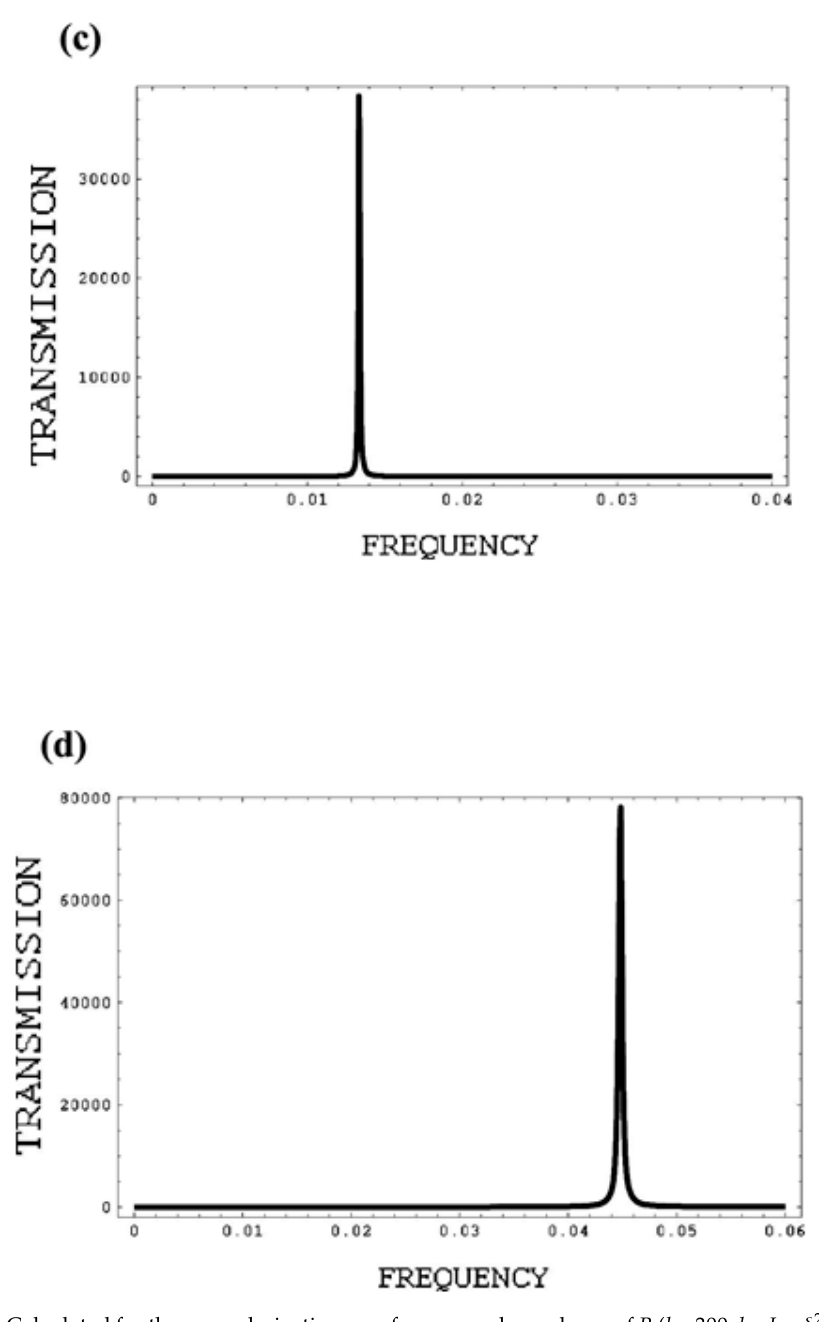
Figure 7. Calculated for the π - π polarization case frequency dependence of R ( l = 300, l = L τ , δ 2 (cos 2 θ ) / 4 = 0.05) ( a ) close to the threshold gain for the first second order lasing edge mode ( γ = − 0.00565), ( b ) close to the threshold gain for the second second order lasing edge mode ( γ = − 0.0129); calculated frequency dependence of T ( l = 300, l = L τ , δ 2 (cos 2 θ ) / 4 = 0.05) ( c ) close to the threshold gain for the first second order lasing edge mode ( γ = − 0.00565), and ( d ) close to the threshold gain for the second second order edge mode ( γ = − 0.0129).